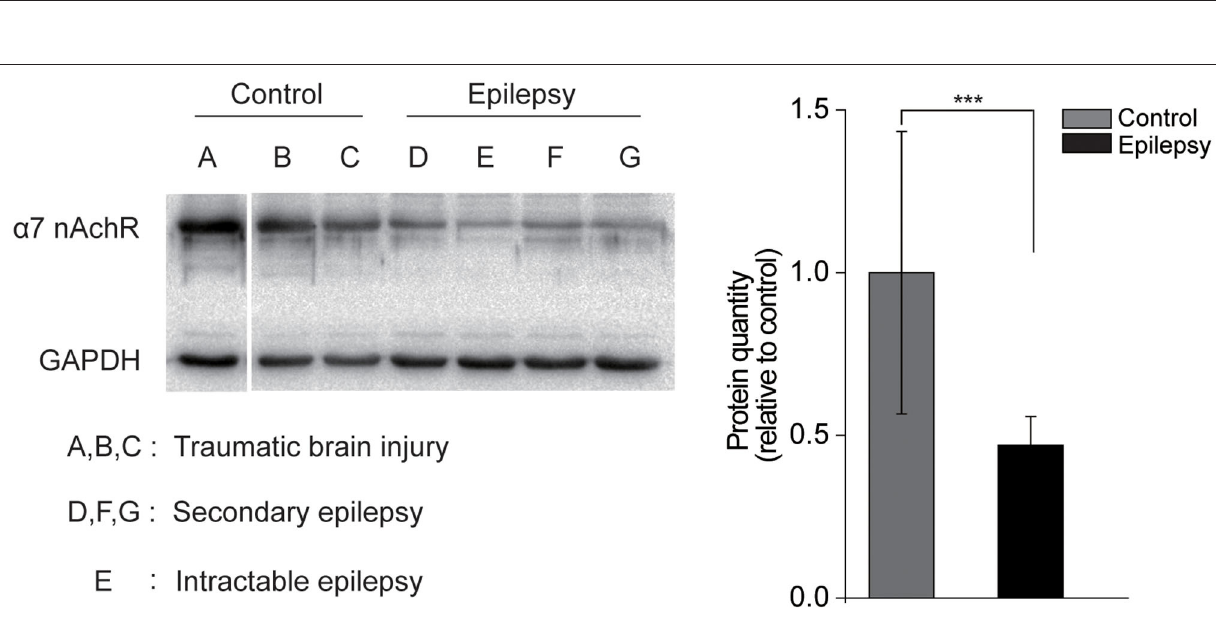
Frontiers in Neurology |